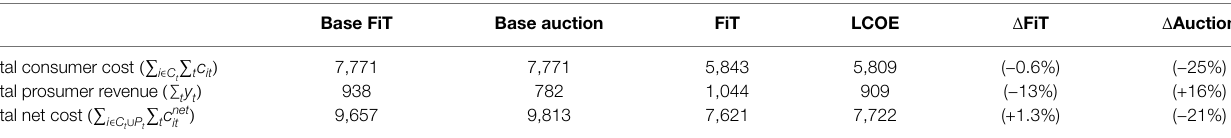
TABLE 2 | Total procurement costs with dynamic pricing thresholds, in